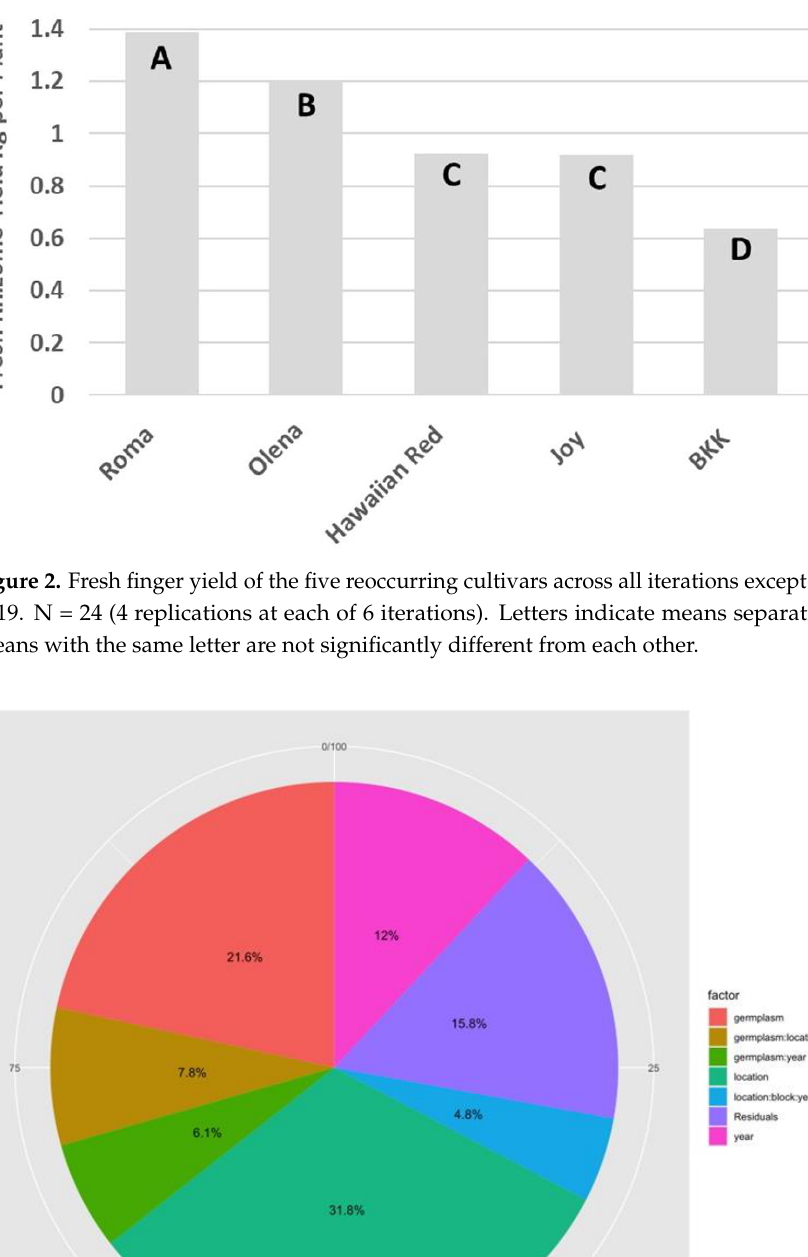
Figure 1. Interaction plot of yield (kg fingers per plant) of cultivars commonly planted at six differ- ent site/year combinations. Data were analyzed as a split plot with site/year as the main plot and genotype as the split plot. Data point are means (N = 4) with standard error bars representing vari- ation.